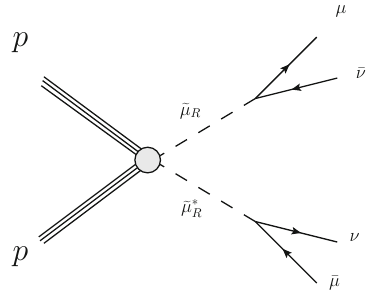
Fig. 7 Production of RH smuon pair, each decaying to a RH muon and neutrino, giving rise to the signal 2 μ + MET